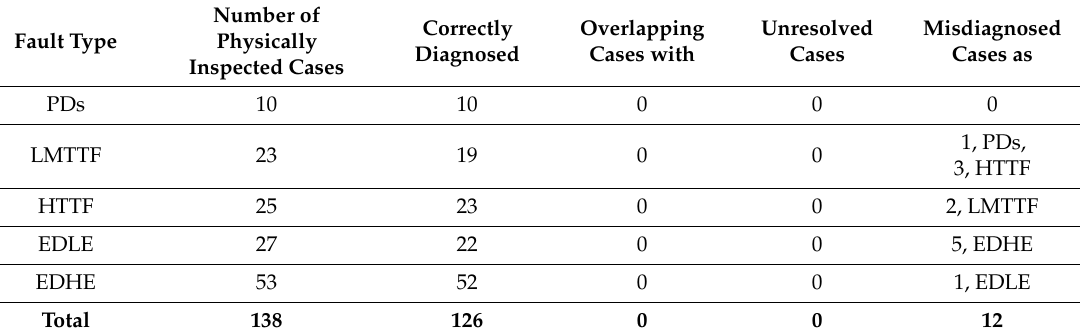
Table 8. Identification of faults using fuzzy logic technique.